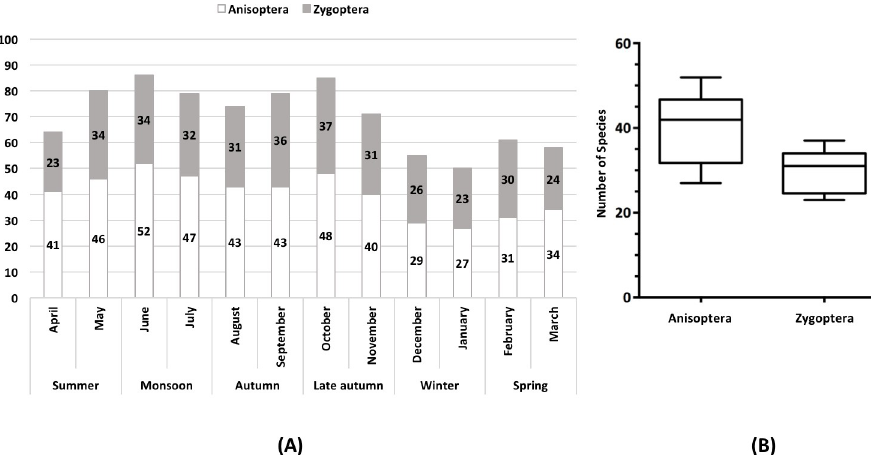
Fig 3. A) Number of Odonata species based on their flight pattern in different seasons of Bangladesh. White bars represent the sub-order Anisoptera and grey bars represent the sub-order Zygoptera. B) A boxplot diagram of